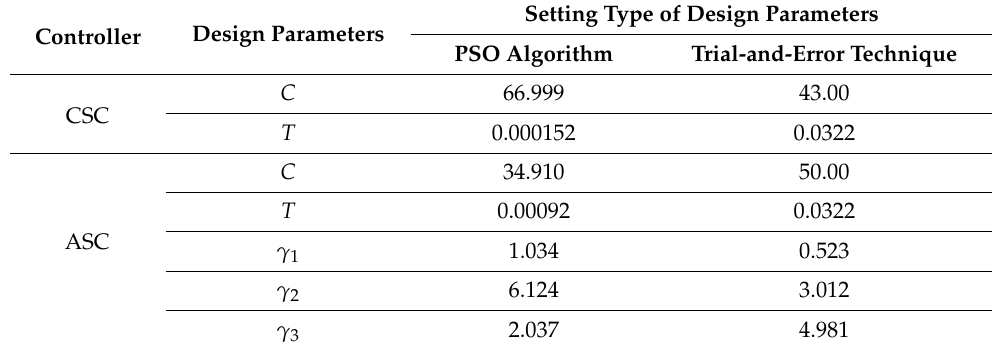
Table 2. Non-Optimal and Optimal settings of ASC and CSC